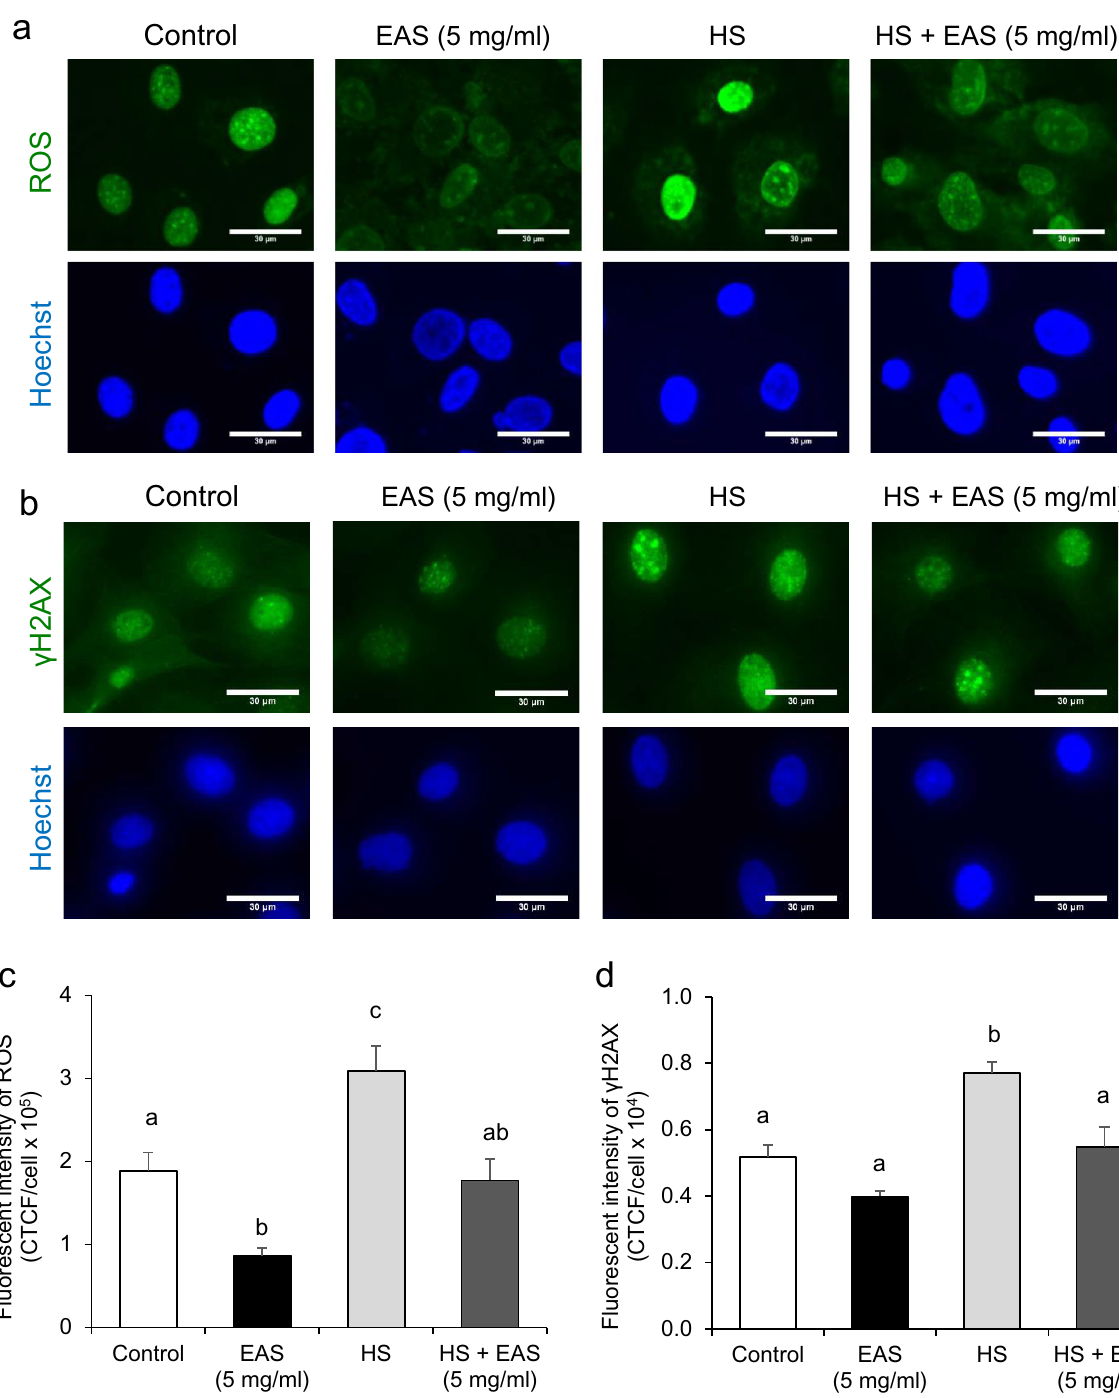
Figure 5. Effect of EAS on induction ROS and DNA damage stained γH2AX immunostaining in the bovine CG cells under non- and HS conditions. Bovine CG cells were treated for 6 h with or without EAS (5 mg/ml) under normal conditions at 38.5 °C (control, EAS group) and HS conditions at 41 °C (HS, HS + EAS group). ( a ) Fluorescence of ROS (upper) and nuclei stained with Hoechst (lower panel). ( b ) Immunostaining for γH2AX (upper panel) and nuclei stained with Hoechst (lower panel). Bar shows 30 μm. ( c ) Fluorescence intensity of ROS (CTCF). Bar shows 30 μm. ( d ) Fluorescence intensity of γH2AX (CTCF). ( c ) Data are shown as the mean ± SEM, n = 5, a vs. b ( P < 0.05), a vs. c ( P < 0.001), b vs. c ( P < 0.05), and ab vs. c ( P < 0.01). ( d ) Data are shown as the means ± SEM, n = 3, a vs b ( P <